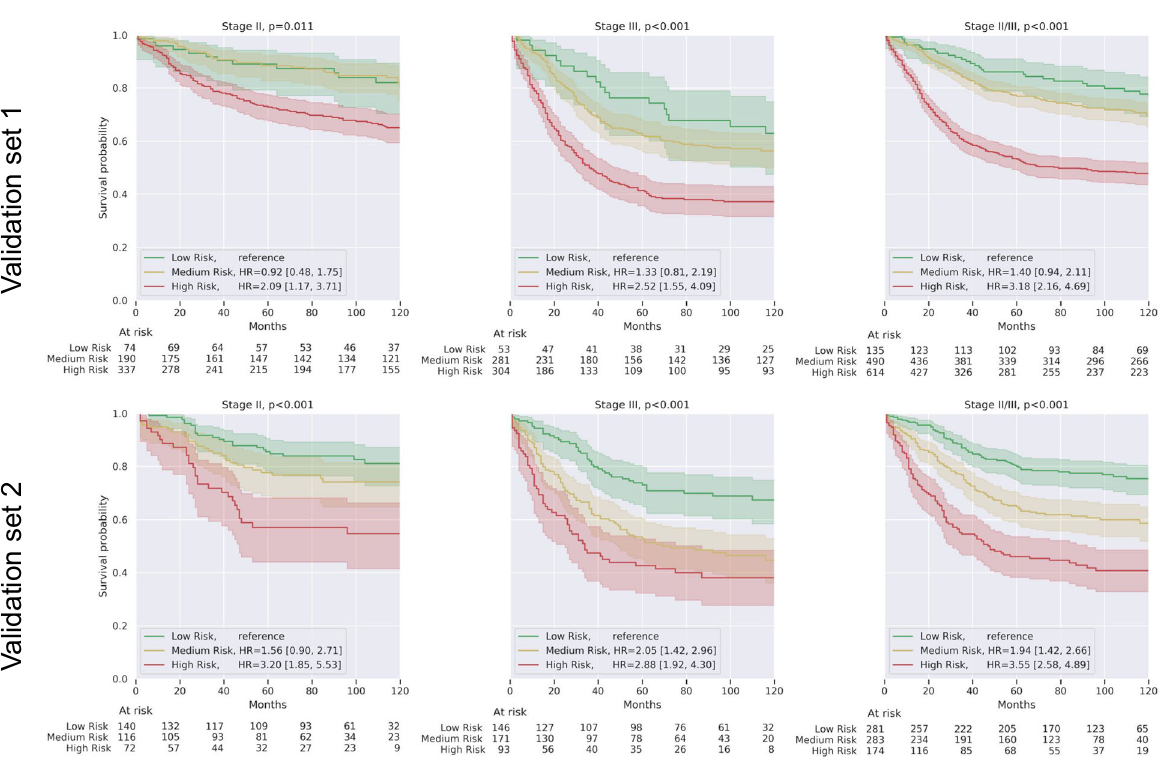
Fig. 1 Kaplan – Meier curves on both validation sets for patients strati fi ed by the prognostic deep learning system (DLS). Results are presented for stage II and stage III patients separately, and as a combined cohort (Stage II/III). High- and low-risk groups represent the highest and lowest risk quartiles from the tune set, respectively, based on the DLS prediction. Hazard ratios (HR) for the medium and high-risk groups are provided with the low-risk group as the reference group. Shaded areas represent 95% con fi dence intervals. p Values were calculated using the log-rank test comparing each high-risk group with the corresponding low-risk